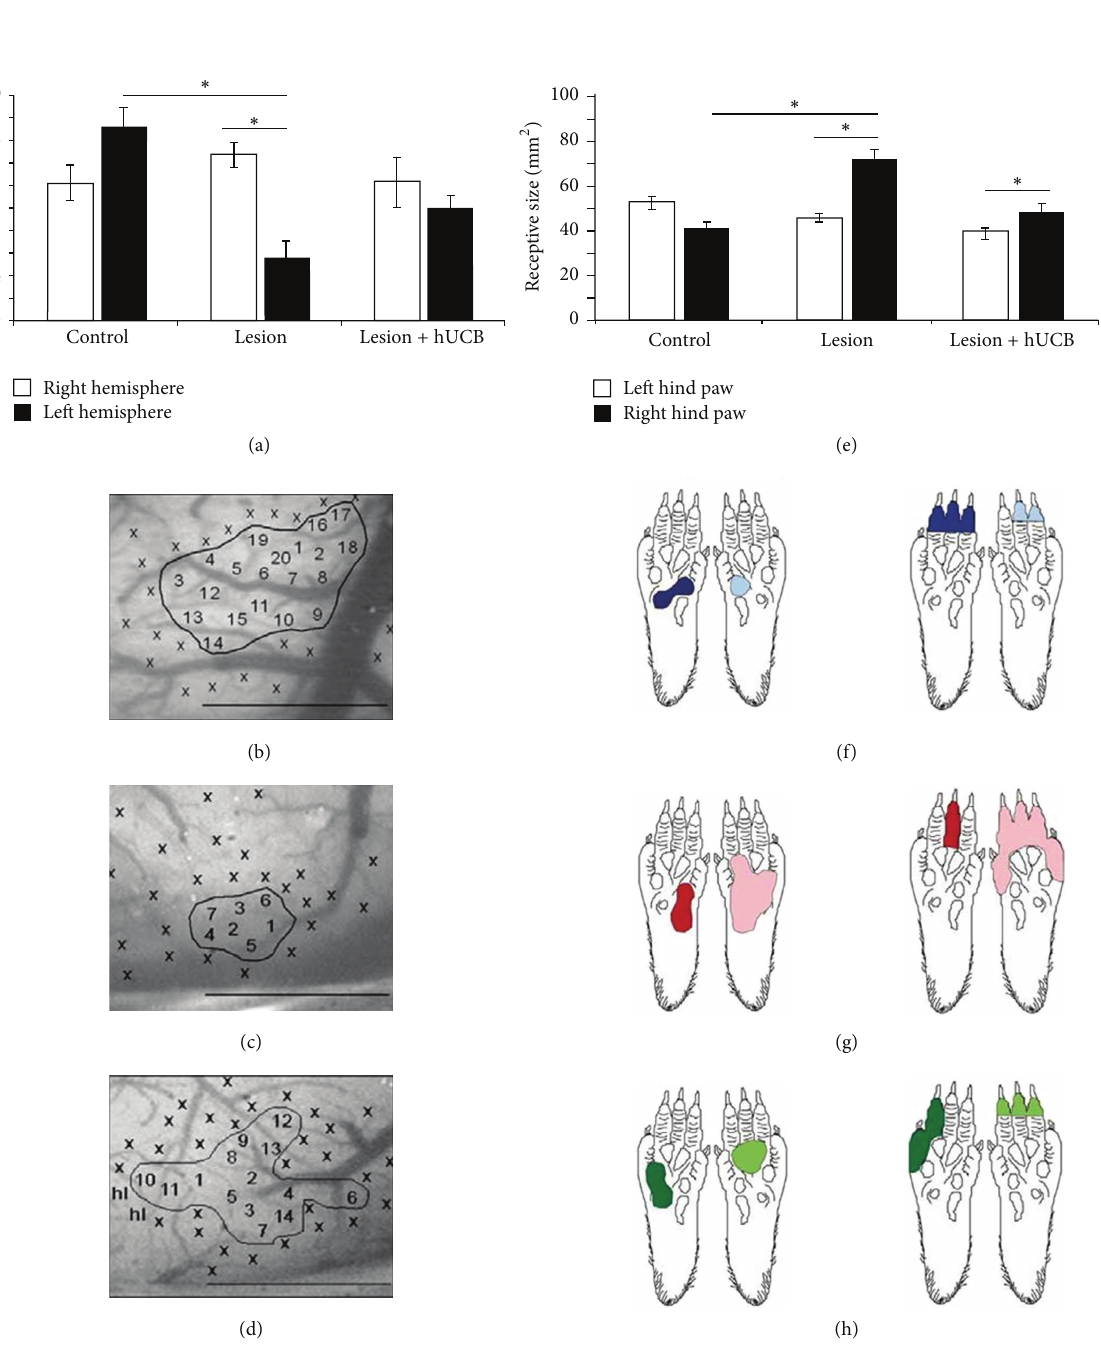
Figure 4: Effects of hypoxic ischemic brain injury and hUCB treatment on receptive field (RF) and cortical map size (see [28]). (a) In lesioned rats the size of the left cortical hindpaw (HP) representation was significantly reduced after hypoxic ischemic brain injury (HI) ( 𝑃 = 0.005 versus controls, 𝑃 = 0.004 versus contralateral hemisphere). Treatment with hUCB cells prevented map changes in the left cortical HP representation. (b)–(d) images of the cortical surface of the left hemisphere of a control (b), lesioned (c), and hUCB treated rat (d). Numbers indicate penetration sites; x indicates noncutaneous responses. hl: hindlimb. Borders of the maps are outlined. Scale bar 1mm. (e) In lesioned rats RF size of the right HP was increased ( 𝑃 = 0.007 versus controls, 𝑃 = 0.03 versus HP ipsilateral to the lesion). hUCB treatment leads to moderate RF increase, not significantly different from controls ( 𝑃 = 0.558 ). Bars represent sem (f)–(h) examples of RFs on the right and left HP for a control (f), lesioned (g), and hUCB treated rat (h). Number of rats used: control group 𝑛 = 10 , lesion group 𝑛 = 17 , and hUCB group 𝑛 = 6 . A total of 975 RFs were recorded (left hemisphere: control 127: lesioned 97, treated 85; right hemisphere: control 192, lesioned 327, and treated 147). doi: 10.1371/journal.pone.0020194.g003. This paper is available online